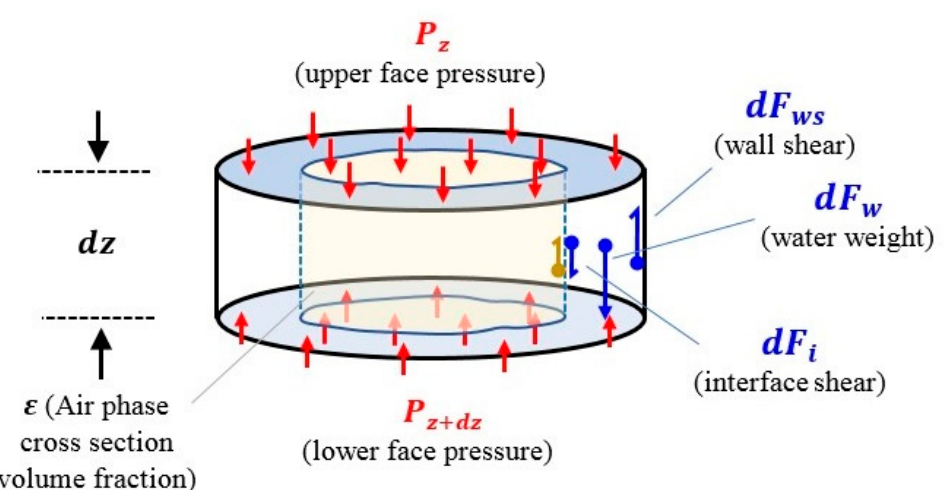
Figure 3. The forces and surface face pressures which act upon an element of a developing vertical- downwards annular flow.